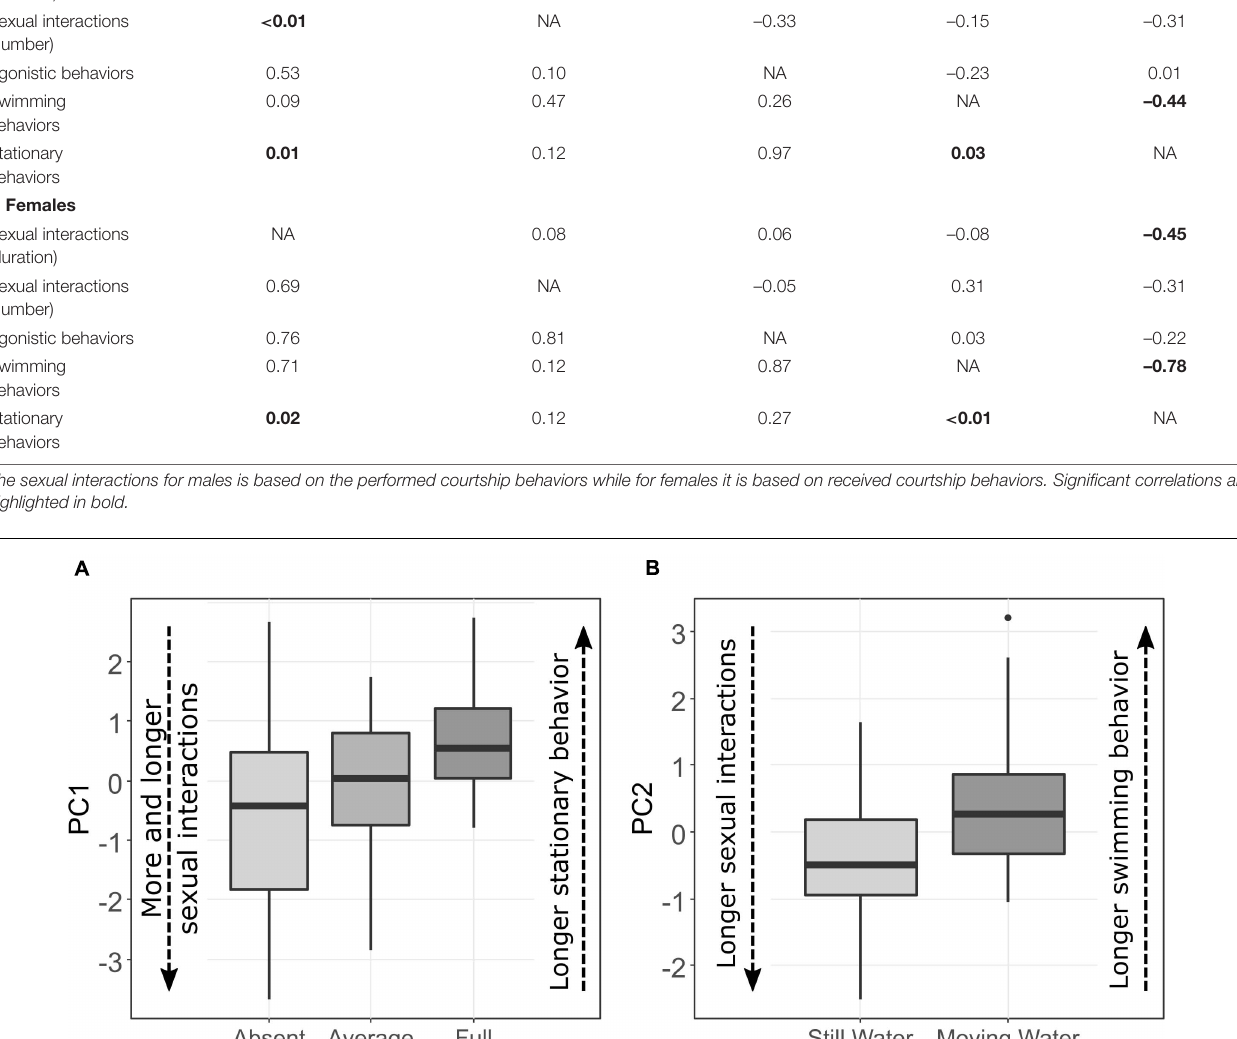
of swimming behaviors in sites with moving water ( Figure 1B